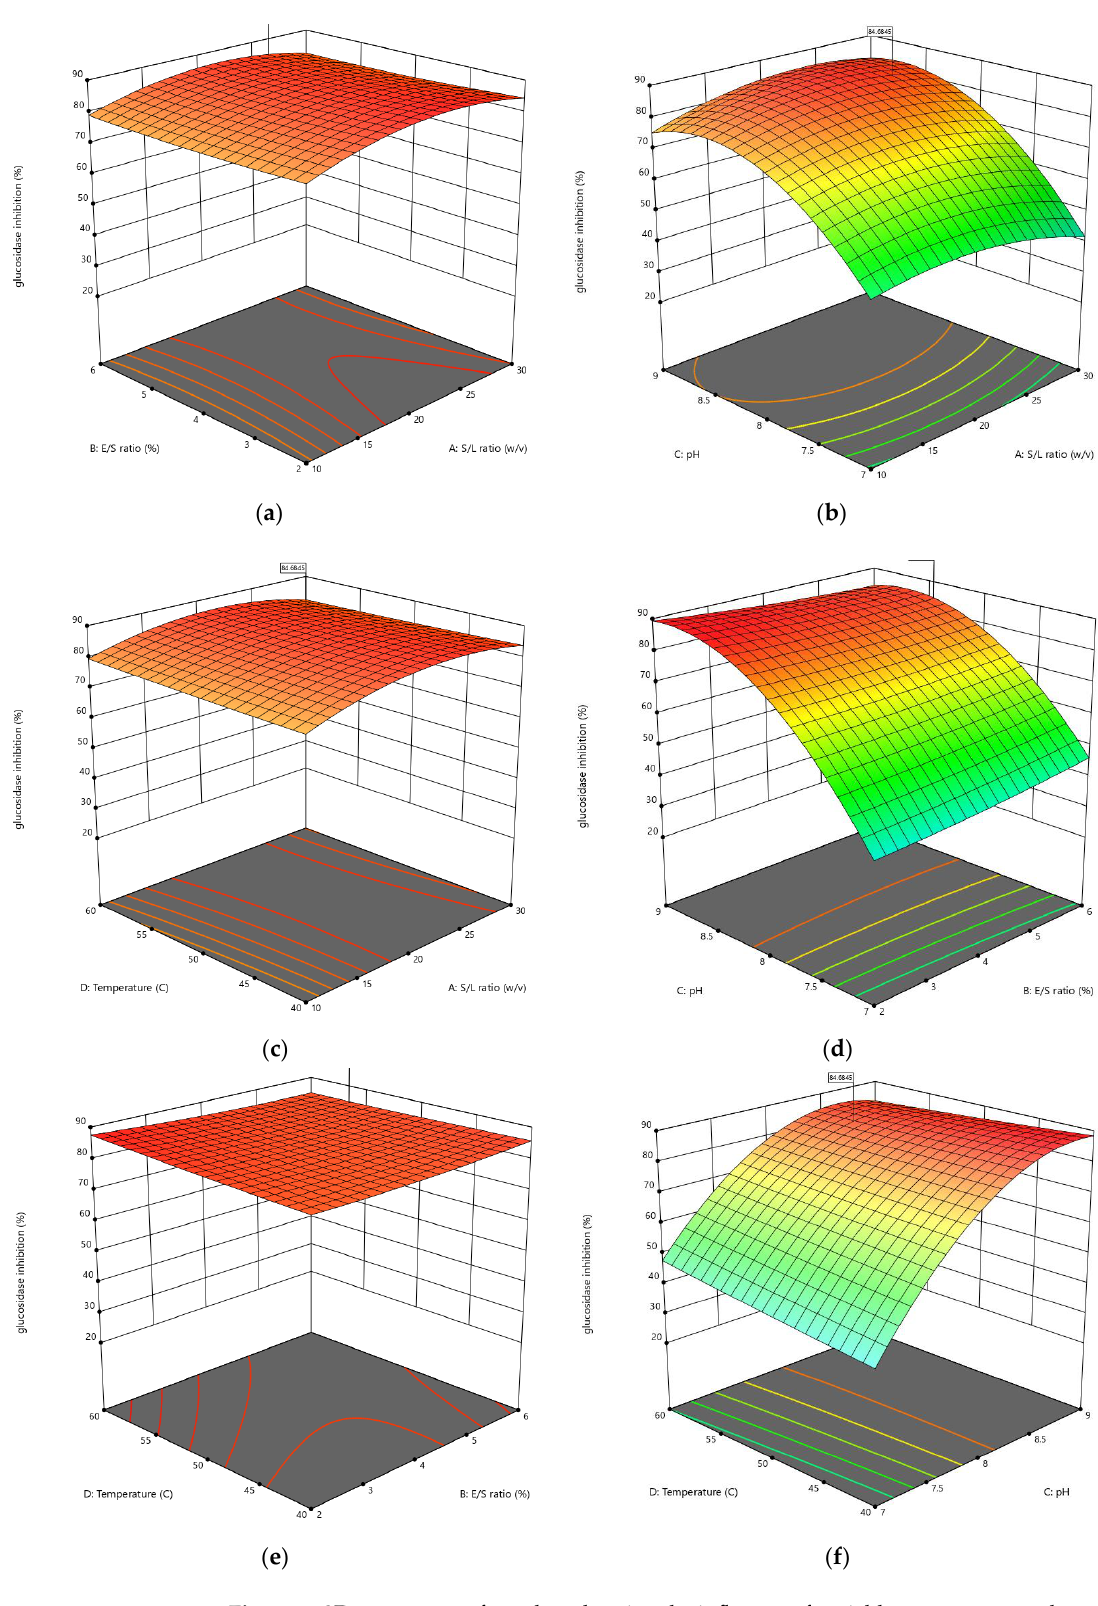
Figure 5. 3D response surface plots showing the influence of variable parameters on the α -glucosidase inhibition activity response using alcalase: ( a ) E/S ratio vs. S/L ratio, ( b ) pH vs. S/L ratio, ( c ) temperature vs. S/L ratio, ( d ) pH vs. E/S ratio, ( e ) temperature vs. S/L ratio and ( f ) temperature vs. pH.